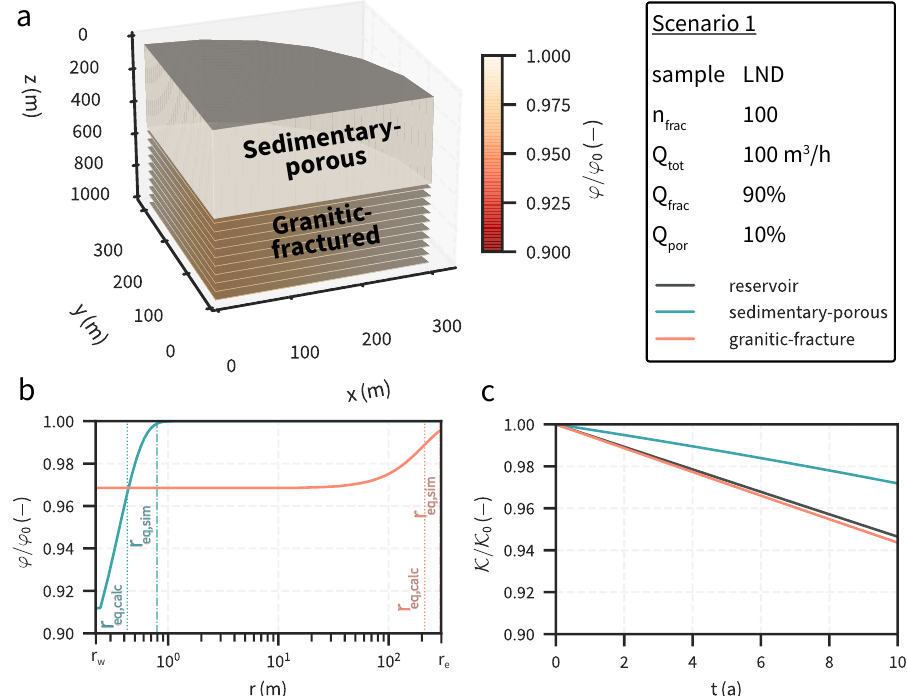
Figure 2. Reservoir simulation results of scenario 1. ( a ) Conceptual view of the reservoir model with the injection well at the origin. ( b ) Porosity change along the horizontal flow axis at the end of the simulation, as well as the previously calculated and simulated equilibrium lengths. ( c ) Effective permeability change in the layers and the reservoir over the duration of the simulation.